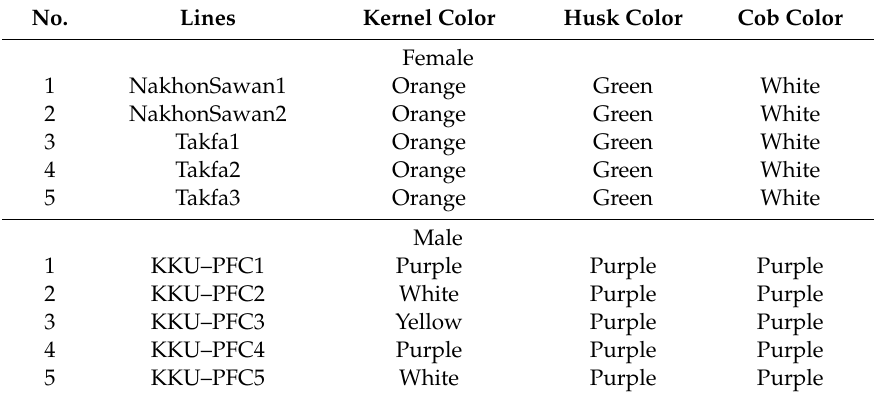
Table 1. List of parent materials used in this